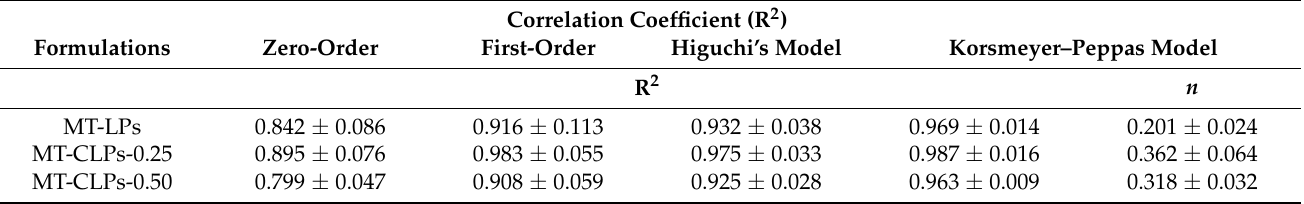
Table 2. In vitro release kinetics models of MT-LPs, MT-CLPs-0.25, and MT-CLPs-0.5 ( n = 3, mean ± SD).